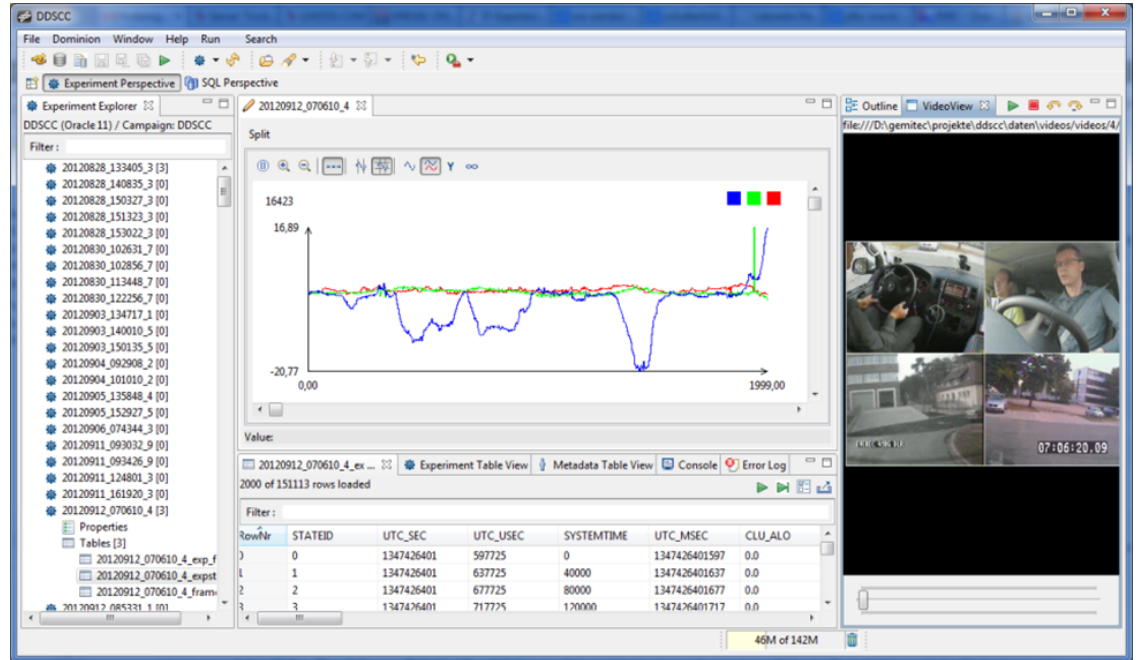
Figure 9: Data plot and synchronous video rendering in